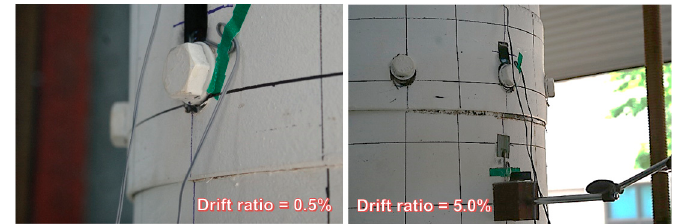
Figure 27. Buckling failure of outer tube of SP-H.